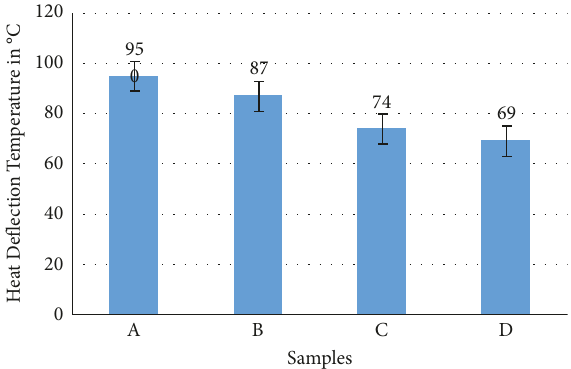
Figure 4: Heat deflection temperature of basalt fiber composite.